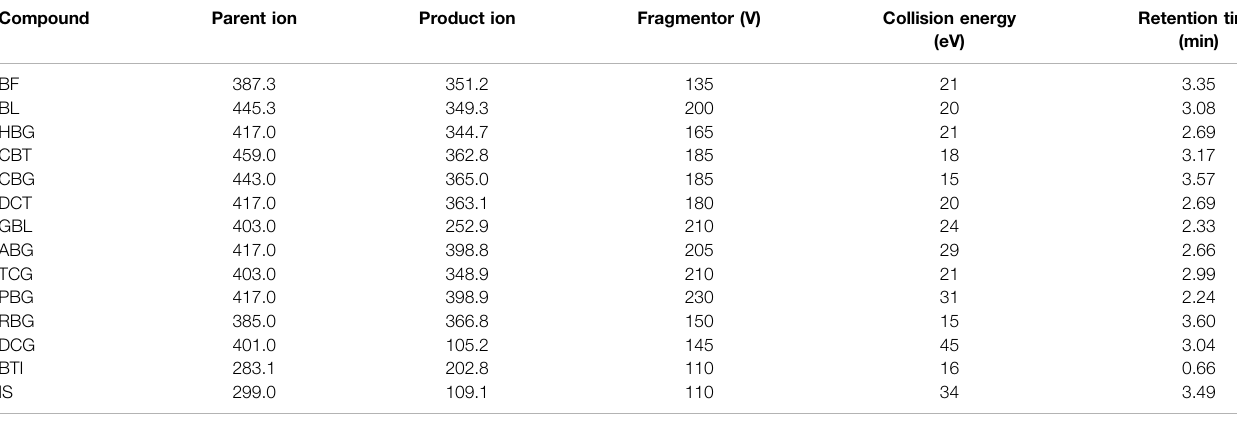
TABLE 1 | Monitoring parameters of the mass spectrometer detector. Compound